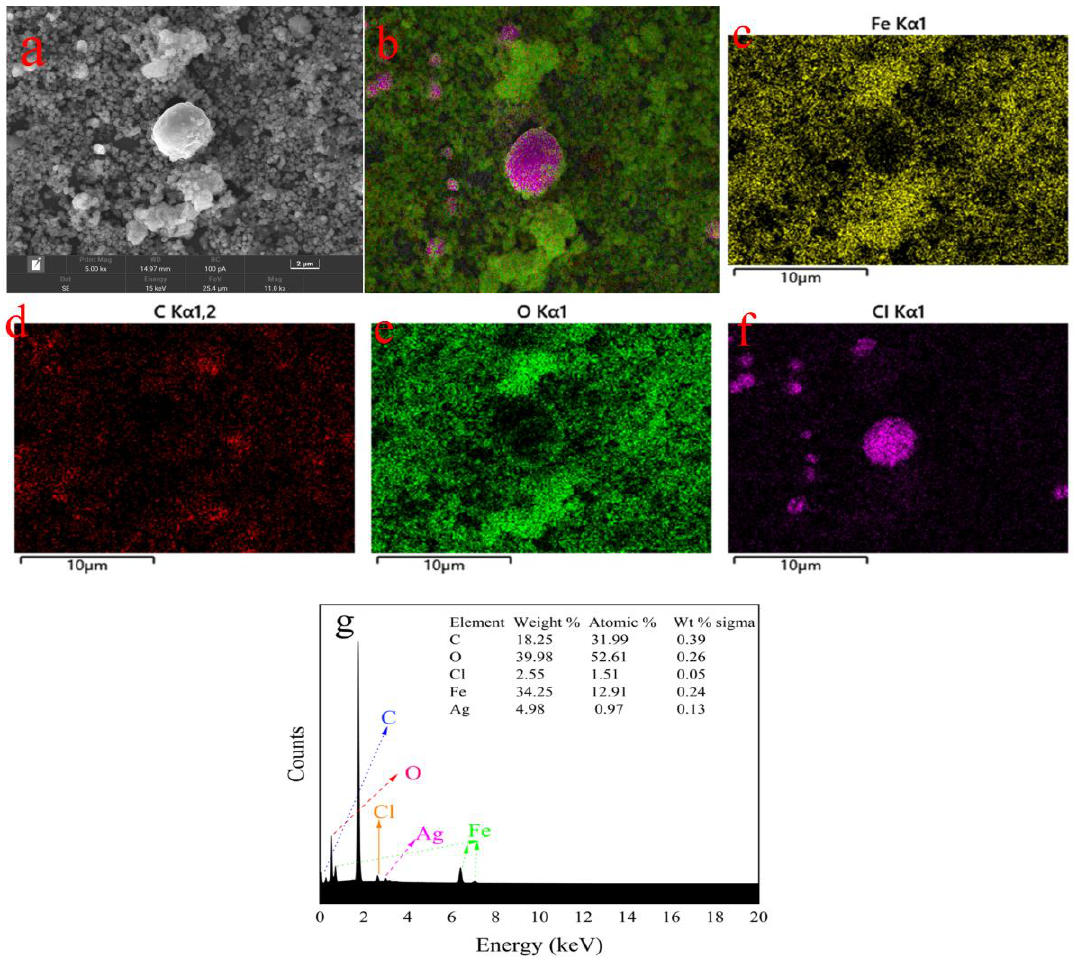
Figure 11. SEM images and EDS spectral analysis of MIL-101(Fe)@Ag (Ag 0.0127 wt%). Table 1. Inhibition-zone diameters of MIL-101(Fe) and MIL-101(Fe)@Ag (Ag 0.0127 wt%) (mm).